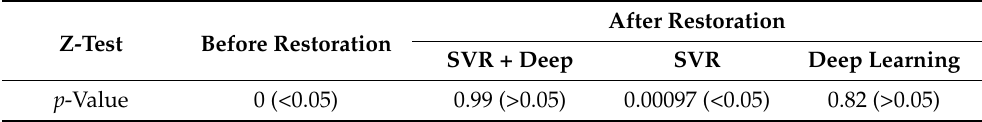
Table 2. Z-test of before and after rPPG restoration for statistical validation.